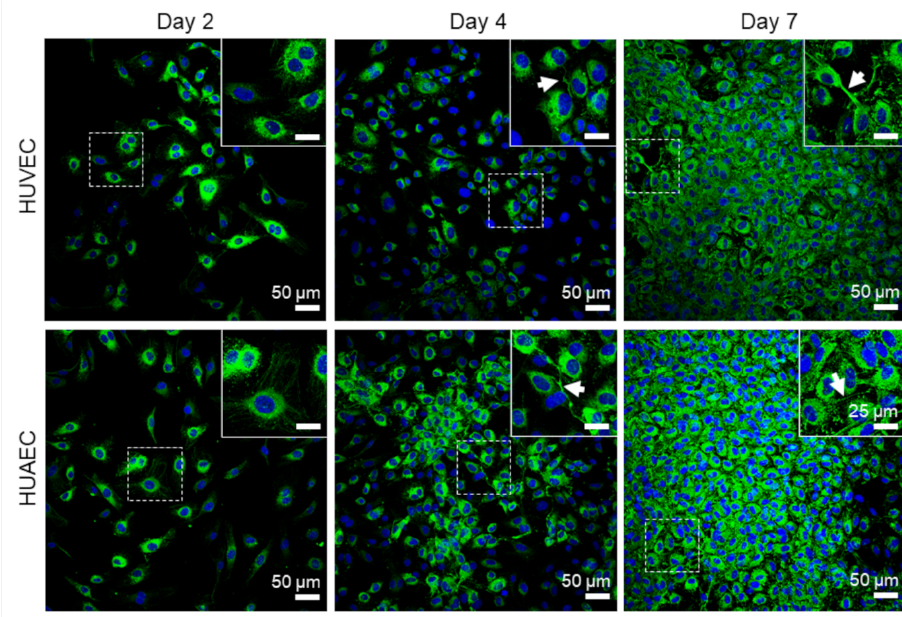
Figure 6. Expression of von Willebrand factor (vWF) by endothelial cells. Human umbilical cord-derived endothelial cells from veins (HUVEC) or arteries (HUAEC) were seeded at a density of 15,000 cells/well at day 0 and cultivated for 2, 4, and 7 days. Cells from both sources expressed vWF at all time points. At day 4 and 7, some extracellular vWF fibers were observed (white arrows). Fluorescent images were taken at 20-fold primary magnification. Scale bar represents 50 µ m, and 25 µ m in the magnified image sections in the upper right corner of each image. Squares with dashed lines indicate the image region that was